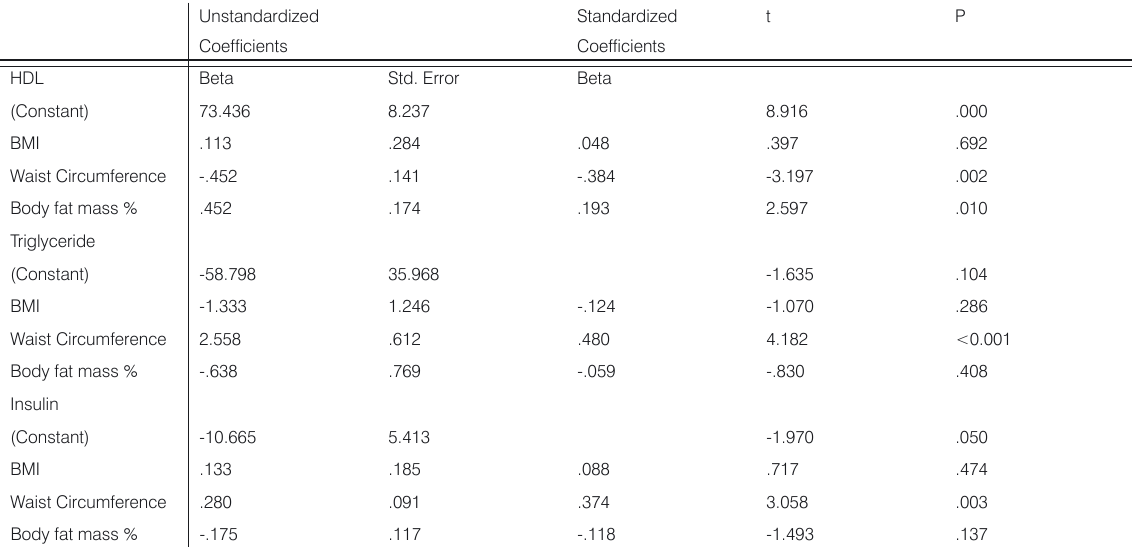
Table 3. Multiple-regression analyses results for anthropometric measurements of biochemical parameters related with cardiovascular risk